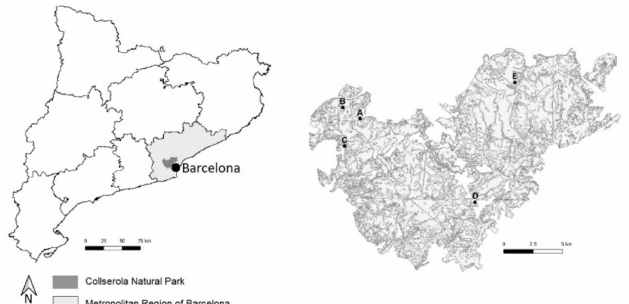
Figure 1. Location of the fields where the PVS trial was performed in 2018 (A, Ortiga, B, Can Dom è nech, and C, Can Puig), the farm where the study started in 2011 (D, Can Mando), and the research station where the breeding program was developed from 2012 to 2017 (E).